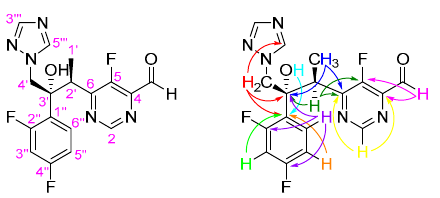
Figure 4. Numbering system and main HMBC connectivities observed in the HMBC spectrum of VN-CHO .